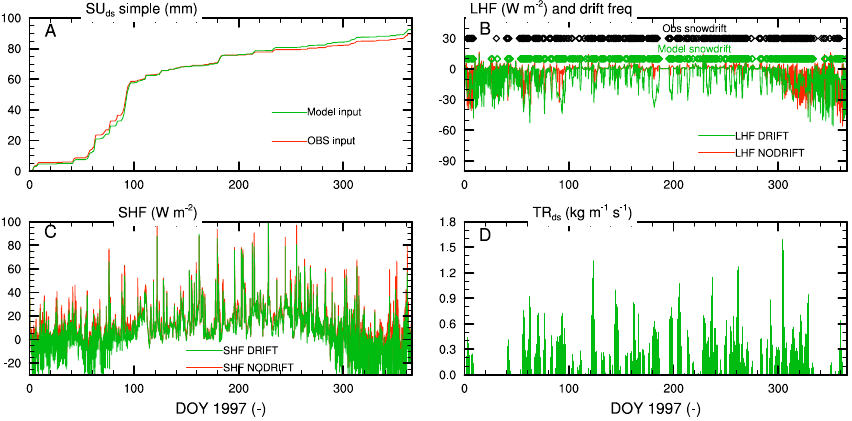
Fig. 7. Time evolution of (A) : cumulative SU ds derived by the simple parameterization (see text), modelled surface fluxes – (B) : latent heat flux; (C) : sensible heat flux, both in Wm − 2 – and snowdrift variables – (B): timing of the snowdrift events in the observations (black) and model (green) and (D) : TR ds . In panel (B) and (C), the green line represents the DRIFT simulation and the red line shows the NODRIFT